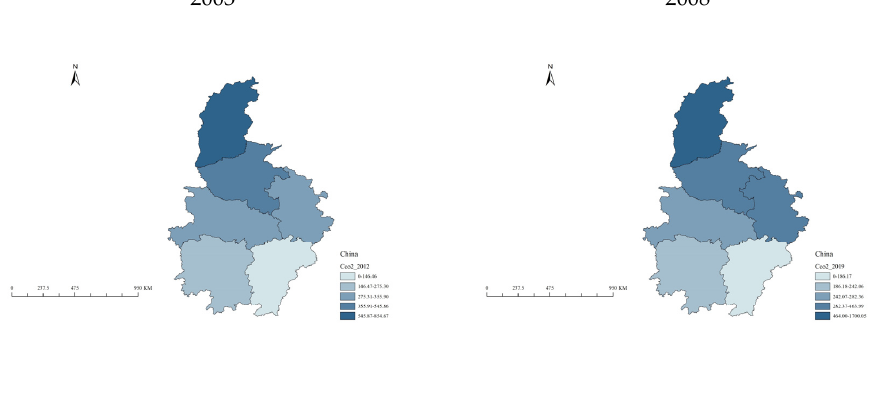
Figure 8. The trend of carbon emission levels in the central China.